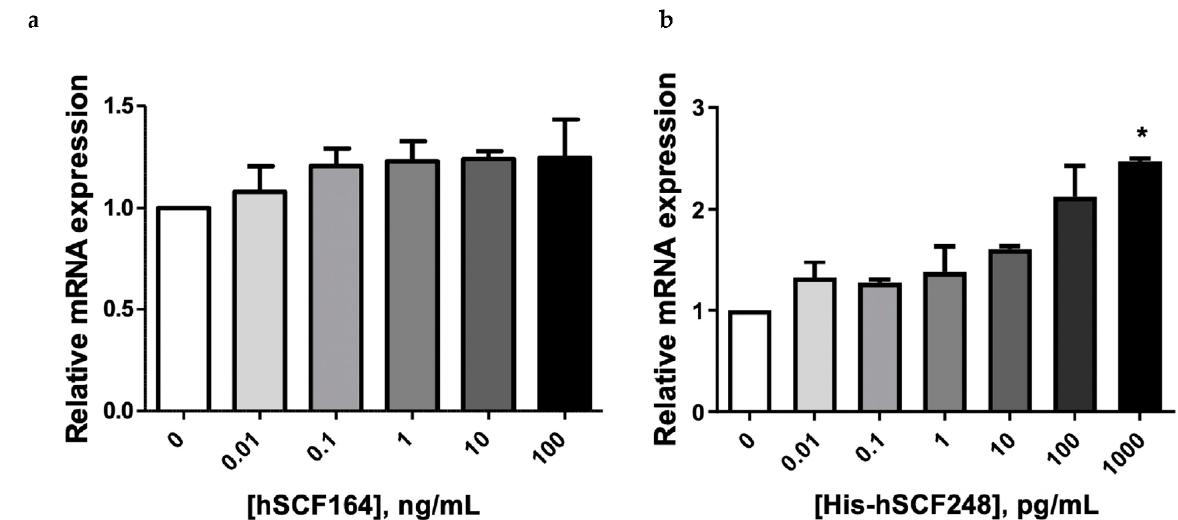
Figure 8. Expression levels of c-Myc mRNA by treatment with hSCF164 and His-hSCF248 in TF-1 cell line. Dose-dependent gene expression changes by treatment with hSCF164 ( a ) and His-hSCF248 ( b ). Gene expression was normalized to RPL mRNA expression. Data are presented as the mean ± SEM ( n = 4). One-way ANOVA and Dunnett post hoc (* p < 0.05).